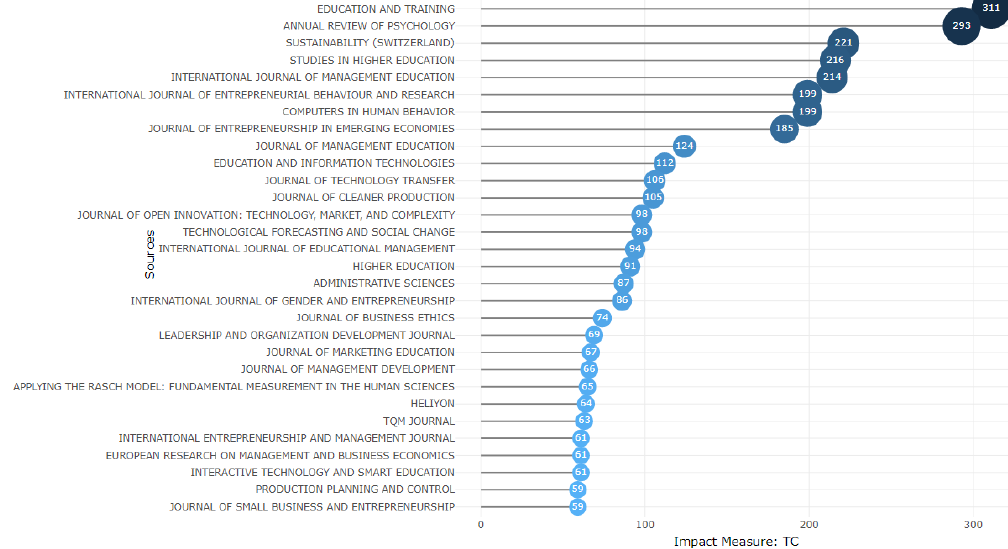
Figure 5. The Total Number of Citations of the Top 30 Journals about the Relationship Between Education and Business Sources: Compiled by the authors using RStudio and Bibliometrix software